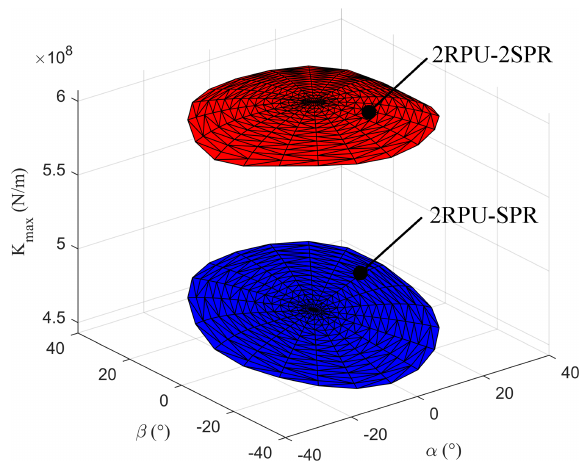
Figure 7. Comparison of maximum